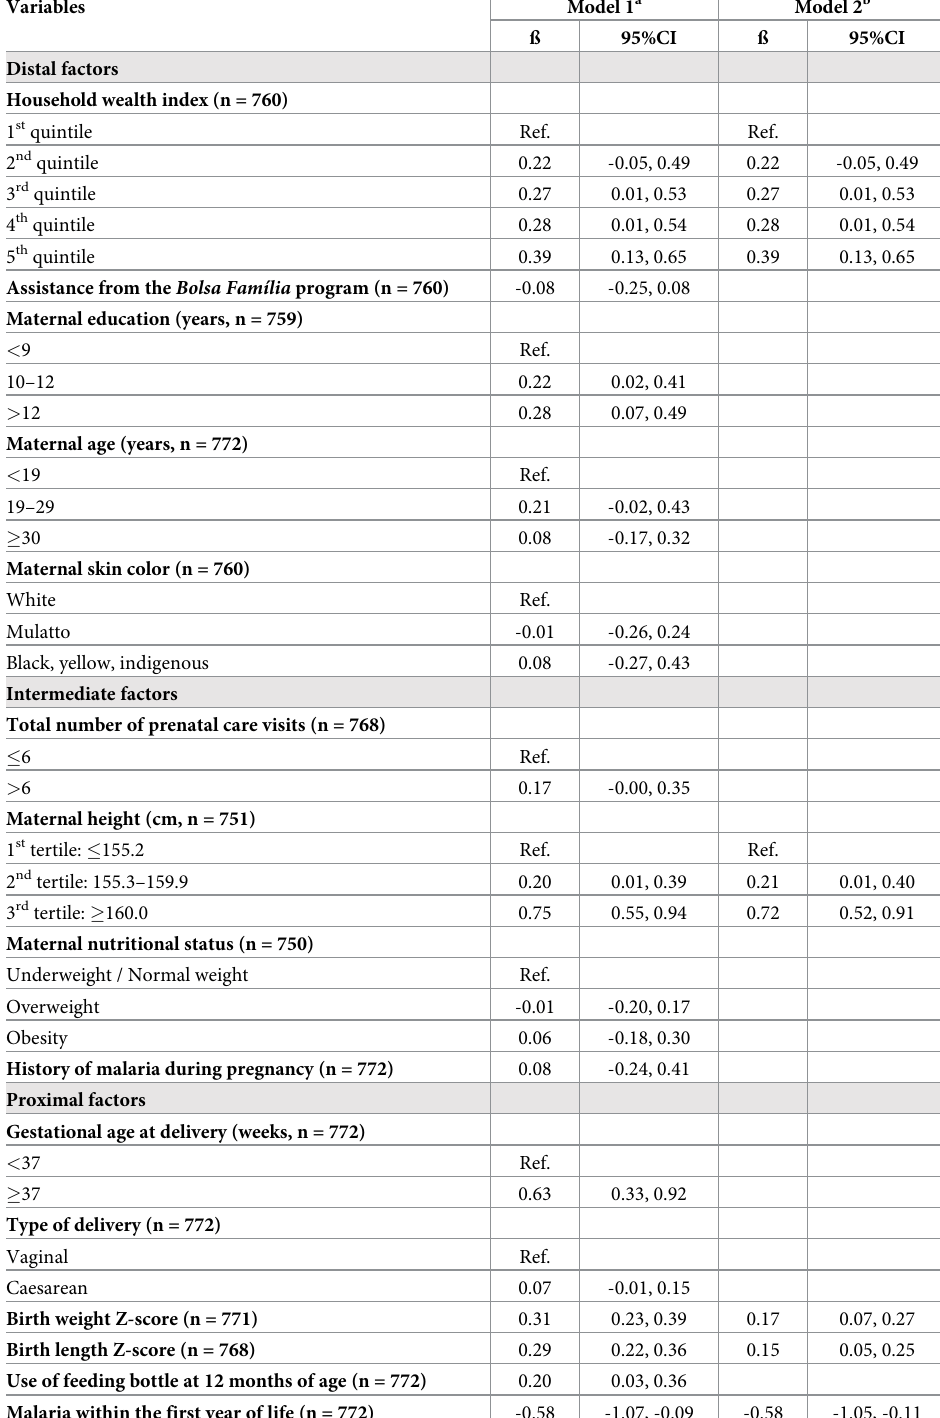
Table 2. Adjusted linear regression coefficients of factors associated with length-for-age Z score (LAZ) at 10–15 months of age, MINA-Brazil Study, Cruzeiro do Sul, Acre,